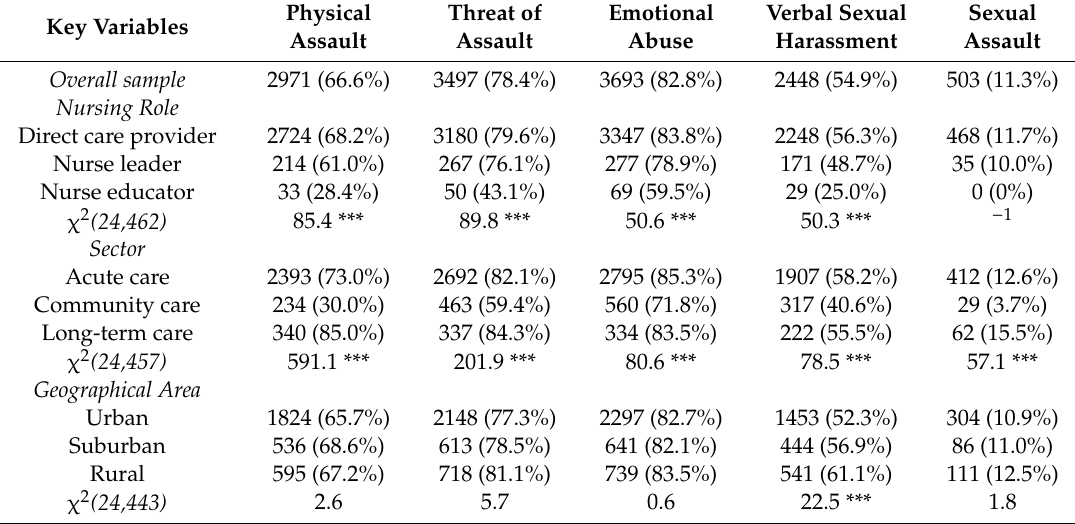
Table 2. Percentage of nurses who reported workplace violence by nursing role, healthcare sector and geographical area.